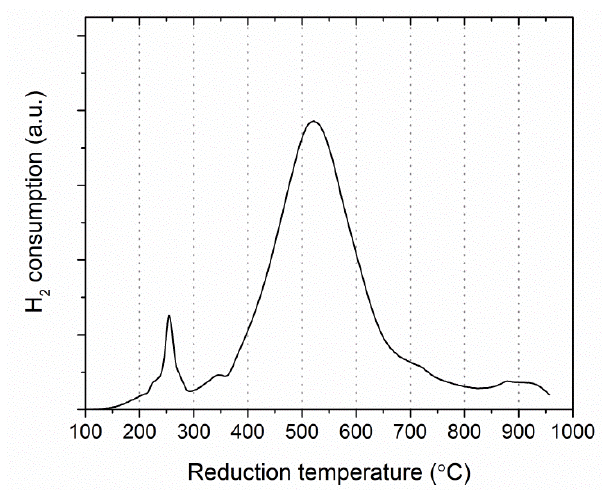
Figure 4. Temperature-programmed reduction profile of NiCuMo-P-SiO 2 catalyst.